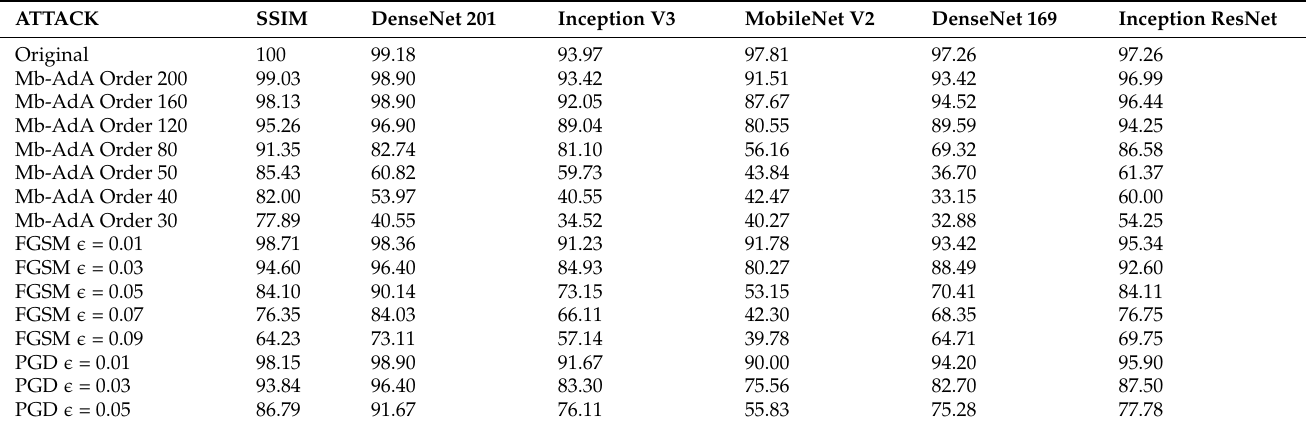
Table 3. Image quality and accuracy in chest X-ray images under attacks (in